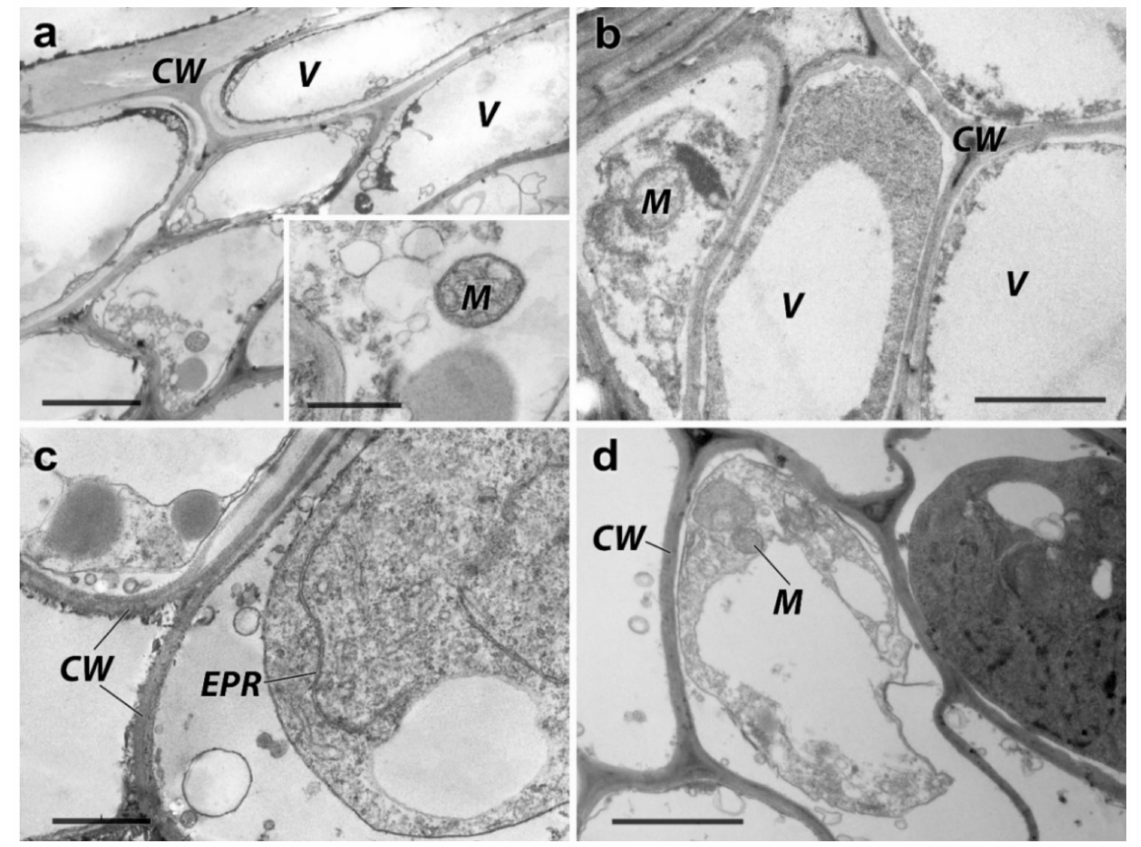
Figure 6. TEM micrographs of ultrathin cross-sections of the roots; T. australis : ( a ) background plot (5K), ( b ) polluted plot (8K); T. laxmannii: ( c ) background plot (T1), ( d ) polluted plot (T4). M—mitochondria; CW—cell wall; V—vacuole; EPR—endoplasmic reticulum. The scale bar is ( µ m): ( a )—0.7, inset—1, ( b )—2, ( c )—1, ( d